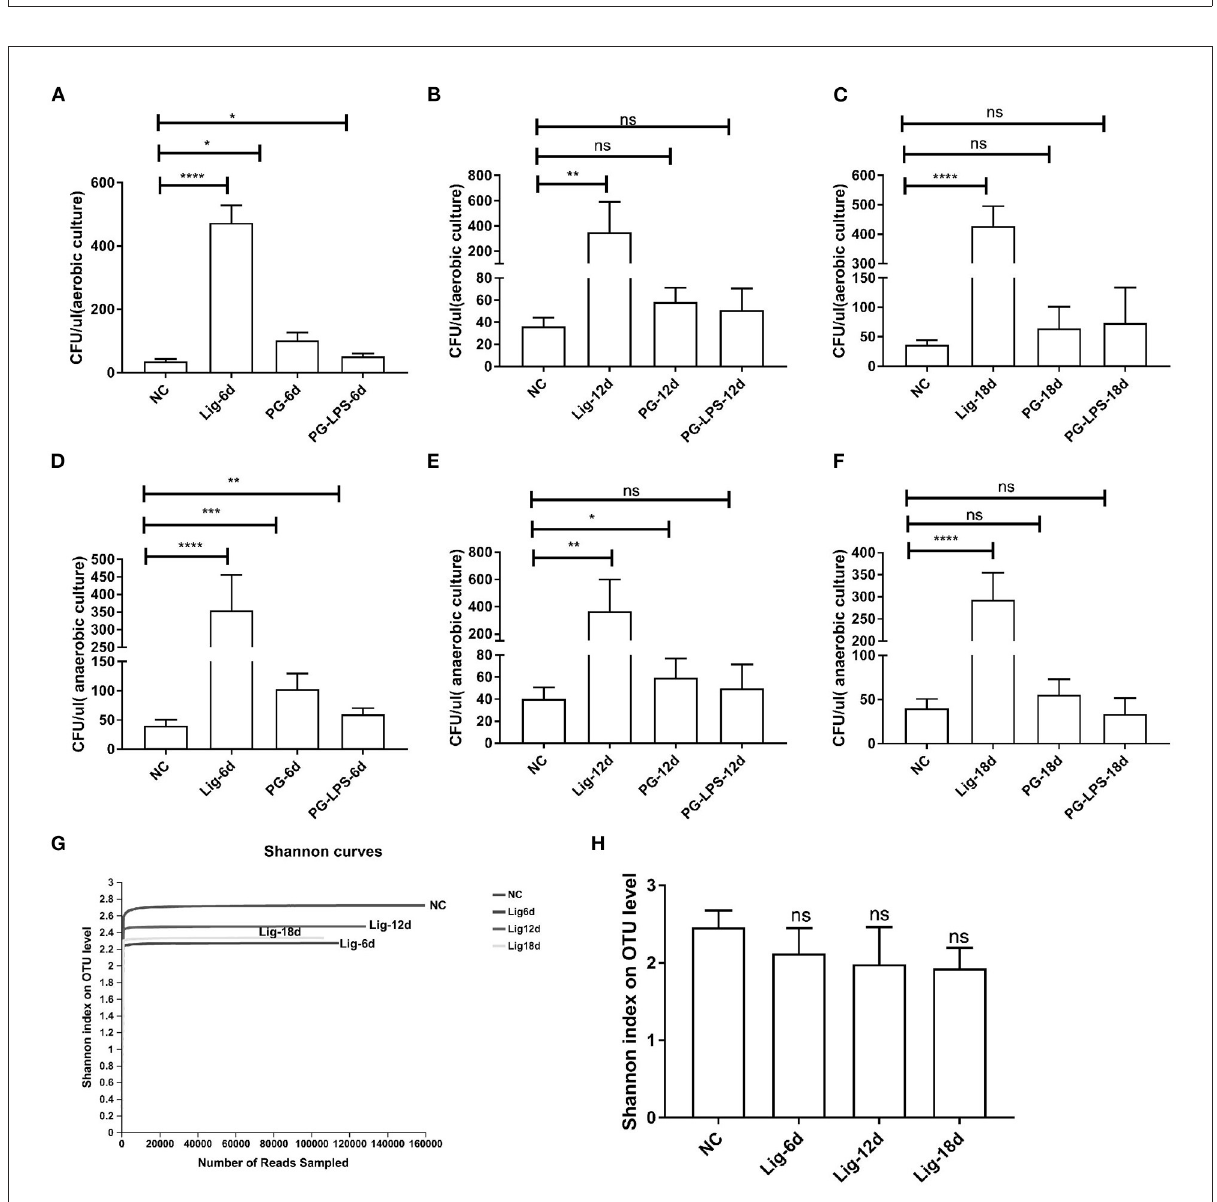
FIGURE2 Bacterial accumulation and α diversity of oral microorganisms in the orthodontic wire ligation model. Bacterial colony numbers from oral cavities under (A–C) aerobic and (D–F) anaerobic conditions. (G) Rarefaction curves for the oral bacterial communities. (H) Shannon diversity index for the orthodontic wire ligature groups. Data represent 3 independent experiments ( n = 6). ns, not significant, * P < 0.05, ** P < 0.01, *** P < 0.001, **** P <